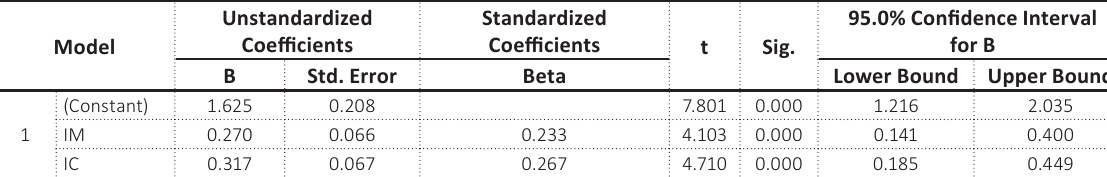
Table 9. Coefficients a for H